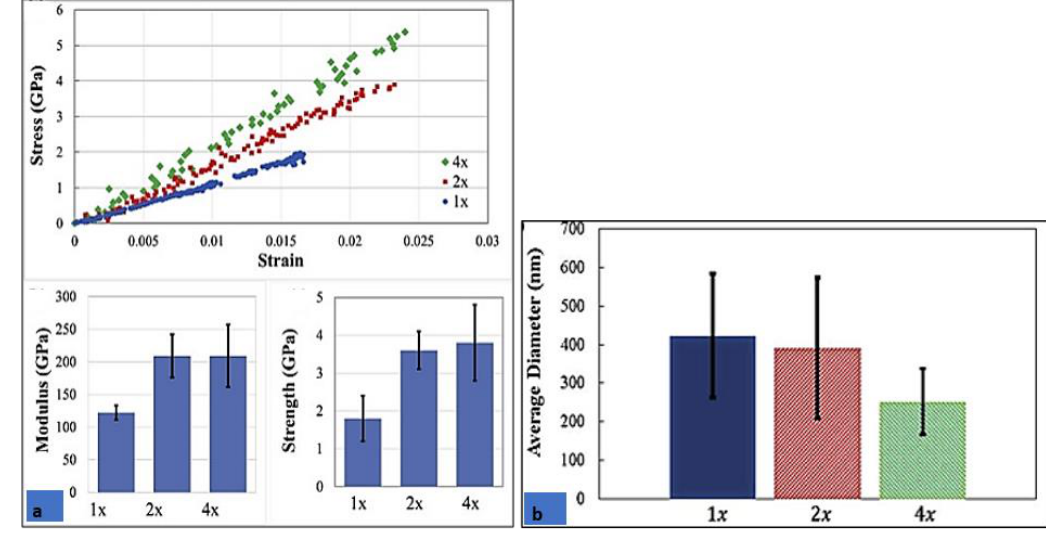
Figure 7. ( a ) Typical stress–strain curve and ( b ) the average fiber diameter of carbon nanofibers (CNFs) [ 139 ] .